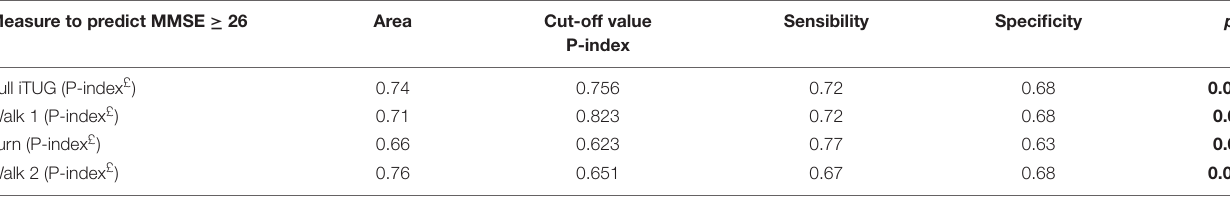
TABLE 2 | Receiver Operating Characteristic Curve (ROC curve) to predict a total MMSE score ≥ 26 points † . Measure to predict MMSE ≥ 26